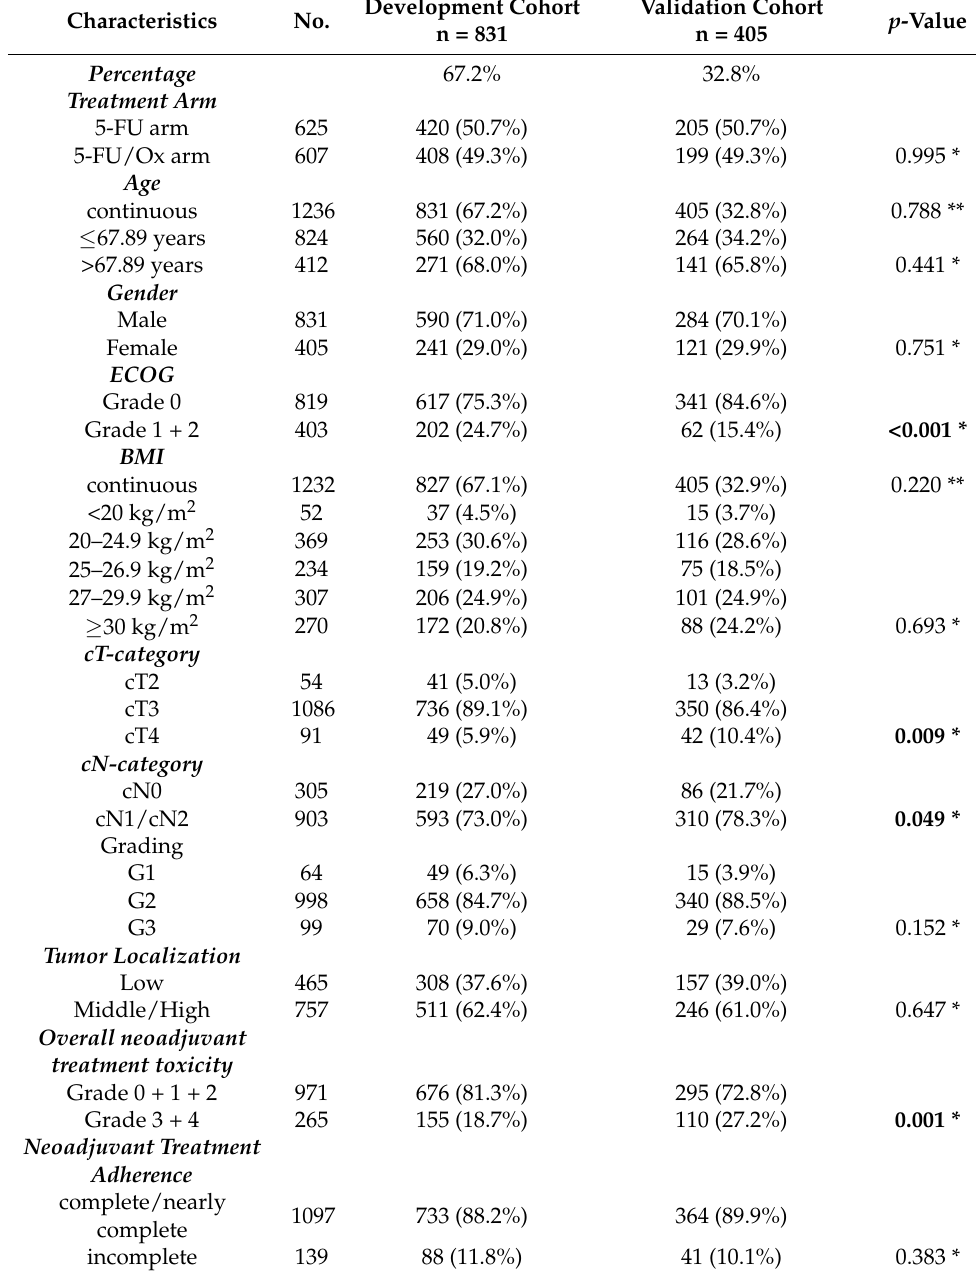
Table 3. Distributions of clinical characteristics and toxicity in the development and validation